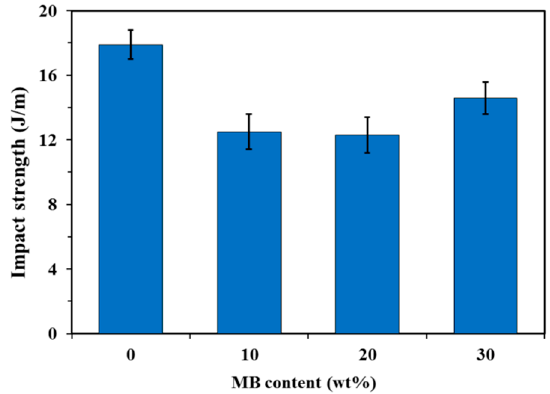
Figure 3. Notched Izod impact strength of the PHBV and PHBV/MB composites.